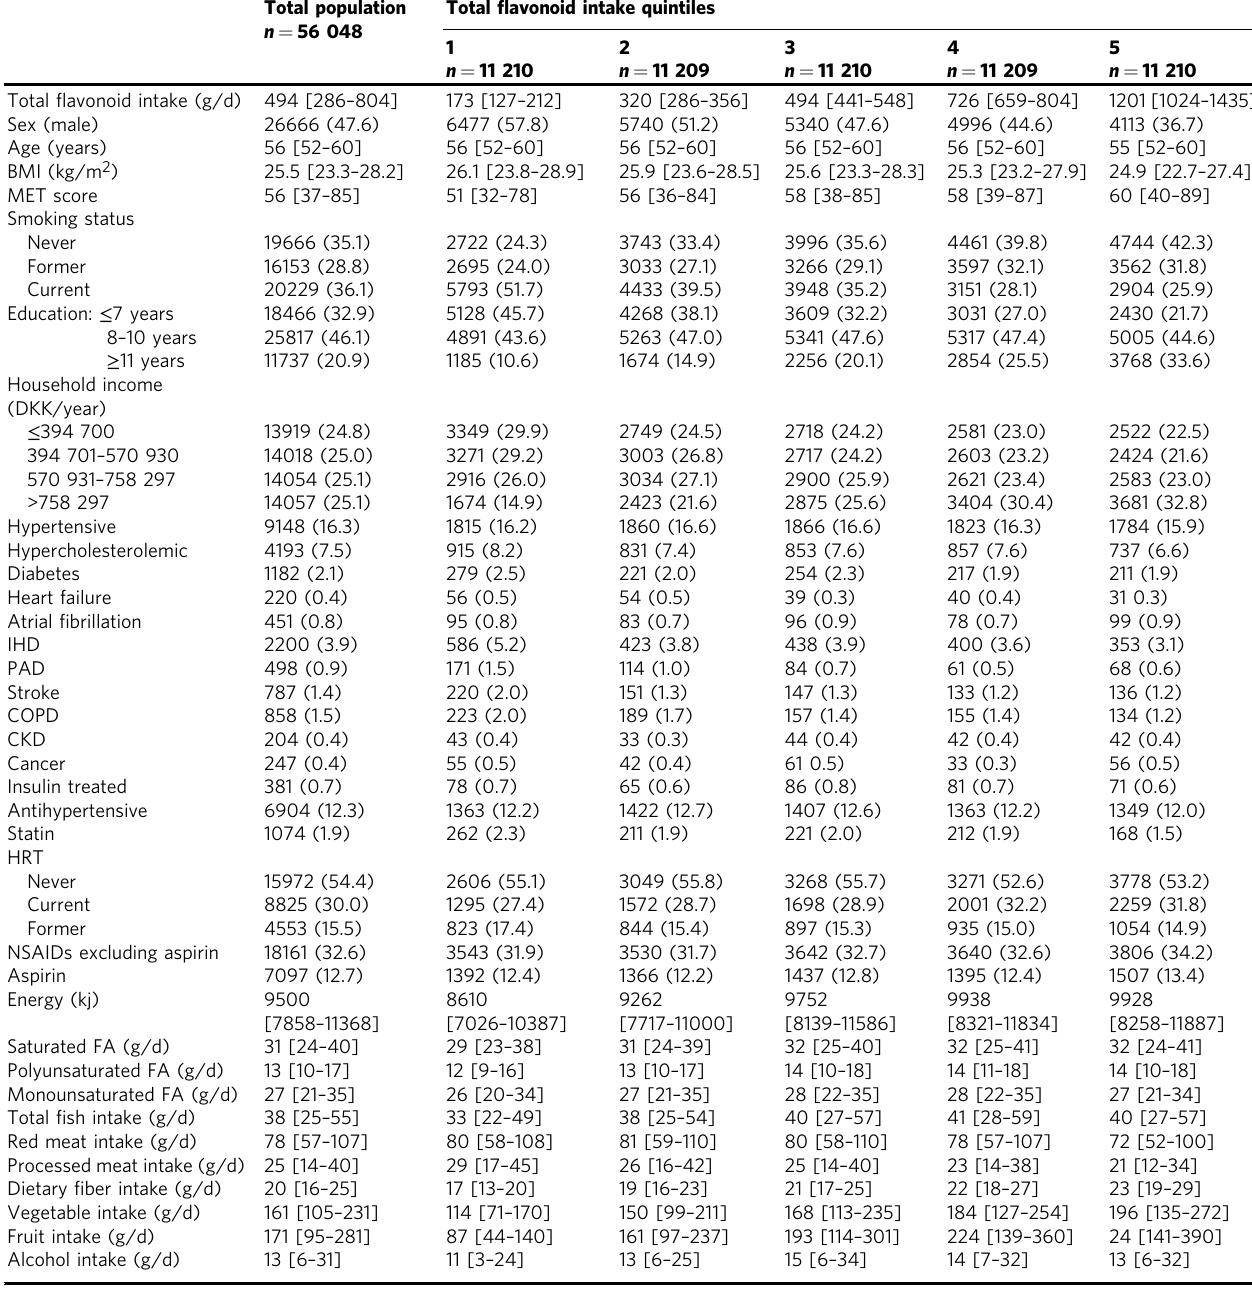
Table 1 Baseline characteristics of study